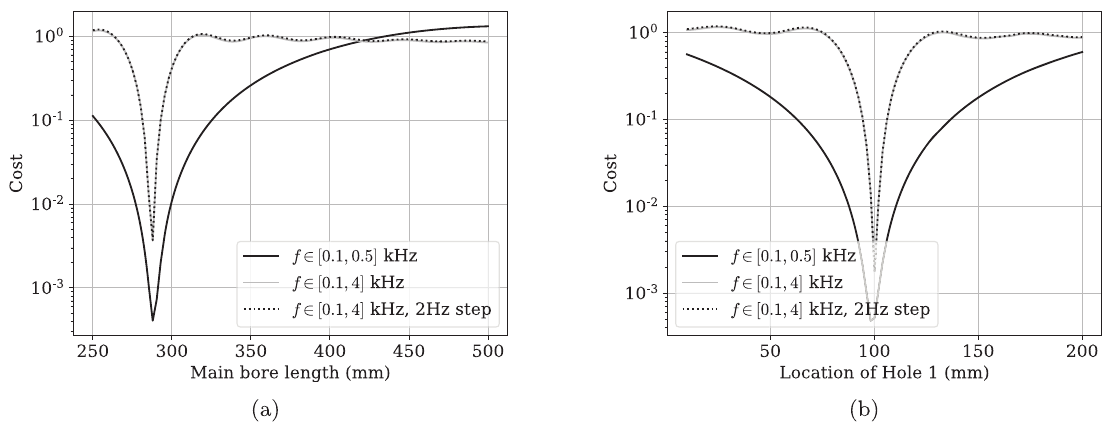
Figure 6. Cost evolution along one dimension of the design space for three frequency ranges: [0.1, 0.5] kHz and [0.1, 4] kHz with a 100 Hz step, and [0.1, 4] kHz with a 2 Hz step. (a) Total length L mb , fi ngering: xxxx ’’ . (b): Location of hole 1 X h 1 , fi ngering “ oxxx ’’ .